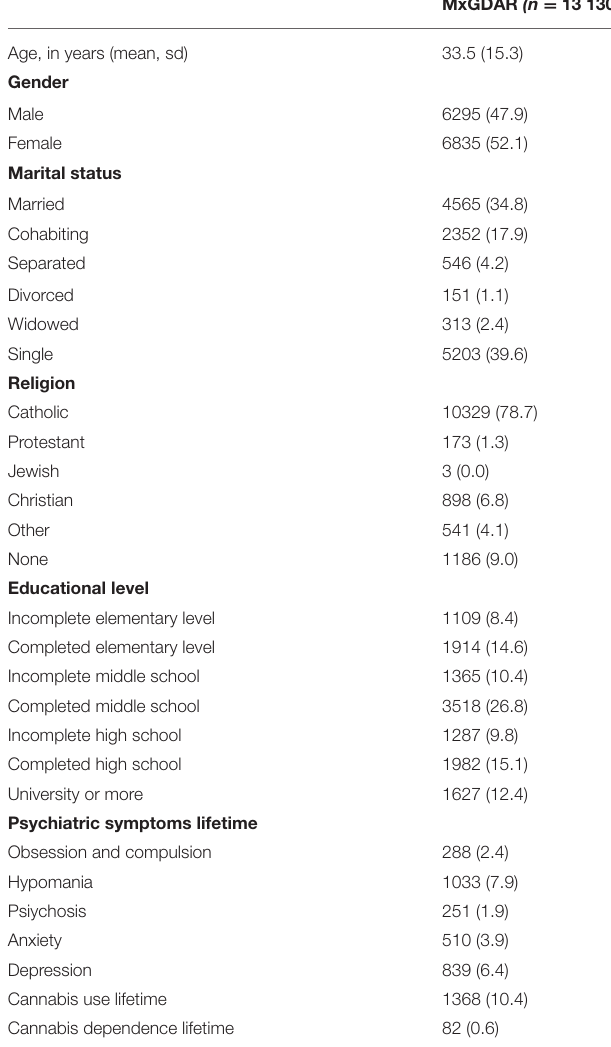
TABLE 1 | Sociodemographic and clinical characteristics of the total